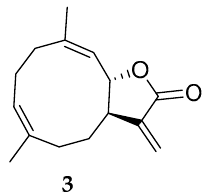
Figure 4. Structure of costunolide ( 3 ).